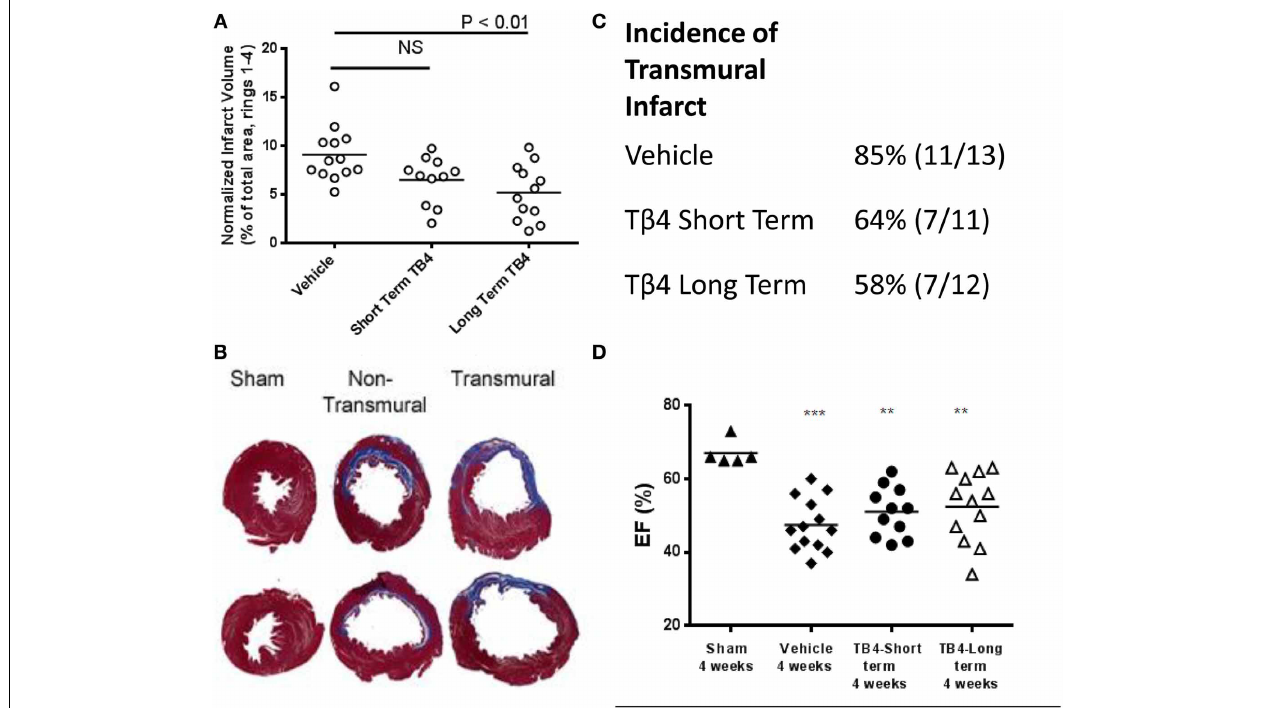
FIGURE 1 | T β 4 treatment reduces infarct volume in the rat 28-days permanent LAD occlusion model, but does not significantly improve ejection fraction. (A) Average infarct volume was significantly reduced by repeated dosing with T β 4. Short term-dosing with T β 4 trended toward reduced infarct volume, but this effect did not reach significance. Each point represents one animal, and the horizontal line represents the average for the